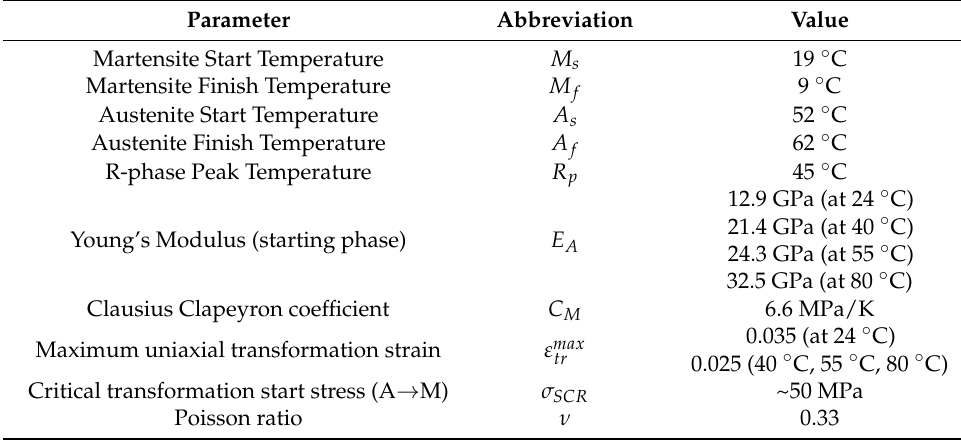
Table A1. List of parameters for finite element